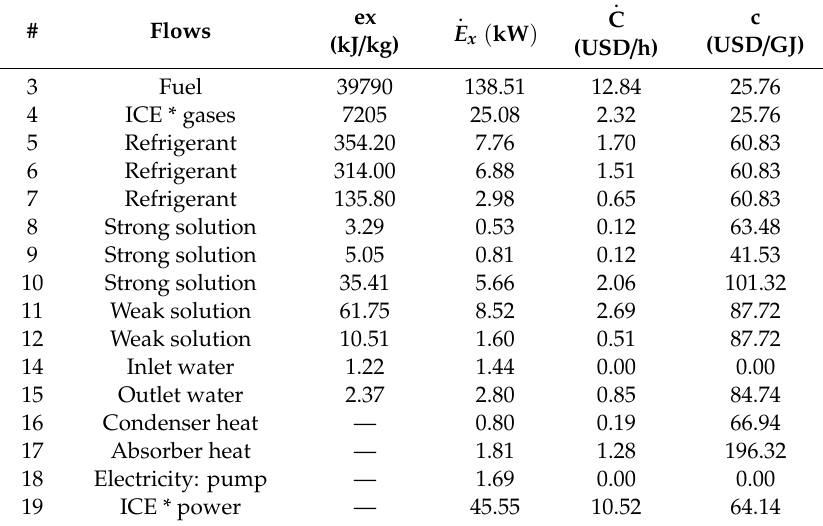
Table 4. Results of exergy costs: SPECO